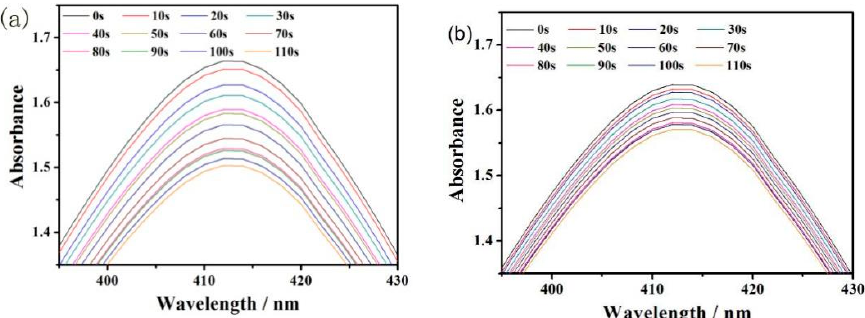
Figure 3. The absorbance values of TPP ( a ) and C1b ( b ) THF solution mixed with DPBF after being irradiated 650 nm laser every 10 s.